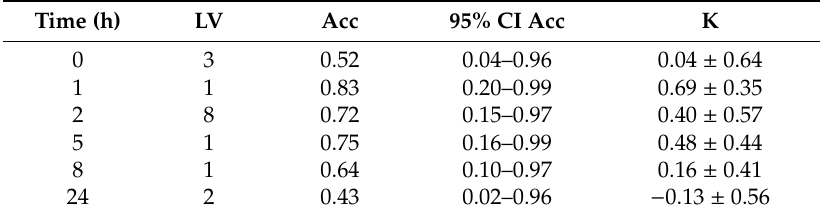
Figure 6. Scores (mean ± standard error) for the first and second principal components from principal coordinates analysis (PCoA) of reflectance data (400–2400 nm) collected from sage leaves, highlighting the capability of spectroscopy to discriminate control (open circle) versus ozonated (200 ppb for 5 h, closed circle) plant groups at 0, 1, 2, 5, 8, and 24 h from the beginning of exposure (gray and dark gray scatter points represent scores for individual control and ozonated samples, respectively). For each time, (i) F- and p -values from permutational analysis of variance (PERMANOVA) for the effects of ozone on full-range (400–2400 nm) reflectance profiles of sage leaves are shown in the top-right corners of panels; (ii) average accuracy (Acc) and kappa (K) values from partial least squares discriminant analysis (PLS-DA, see Table 3) are shown on the bottom-left corners of panels. Table 3. Latent variables (LV), average accuracy (Acc), 95% confidential interval (CI) of accuracy, and kappa (K; mean ± standard deviation) for validation data generated using partial least squares Table 4. F- and p -values of one-way repeated measures analysis of variance (ANOVA) for the effects discriminant analysis (PLS-DA), using 80% of the data for calibration and 20% for validation, for the of ozone (between factor), time (within factor), and their interaction on spectral indices and leaf traits classification of control versus ozonated plant groups from full-range (400–2400 nm) sage spectra, at 0, derived from sage spectra (only leaf traits from well performing PLSR-models were used: validation R 2 > 0.70 and 0.60 for gas exchange and biochemical traits, respectively). df represents the degrees of 1, 2, 5, 8, and 24 h from the beginning of